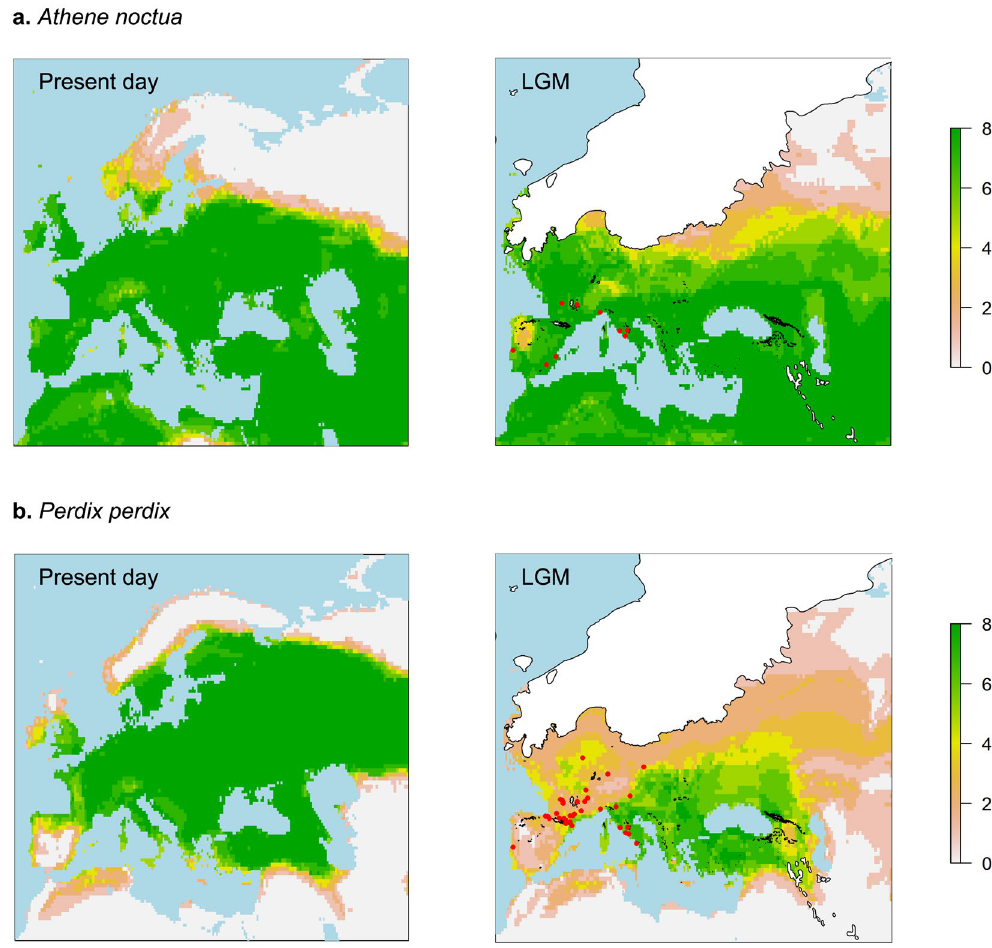
Figure 2. Present-day and LGM ensemble forecasts of the two resident temperate species Athene noctua ( a ) and Perdix perdix ( b ). The ensembles represent an averaging of all the eight projections related to the different GCMs. The values of each cell in the map range from 0 (0 out of 8 models predict the occurrence of the species in that cell, colour light grey) to 8 (all 8 models predict the occurrence of the species in that cell, colour green). The maps were created with R, version 4.0.3 (https:// www.R- proje ct.